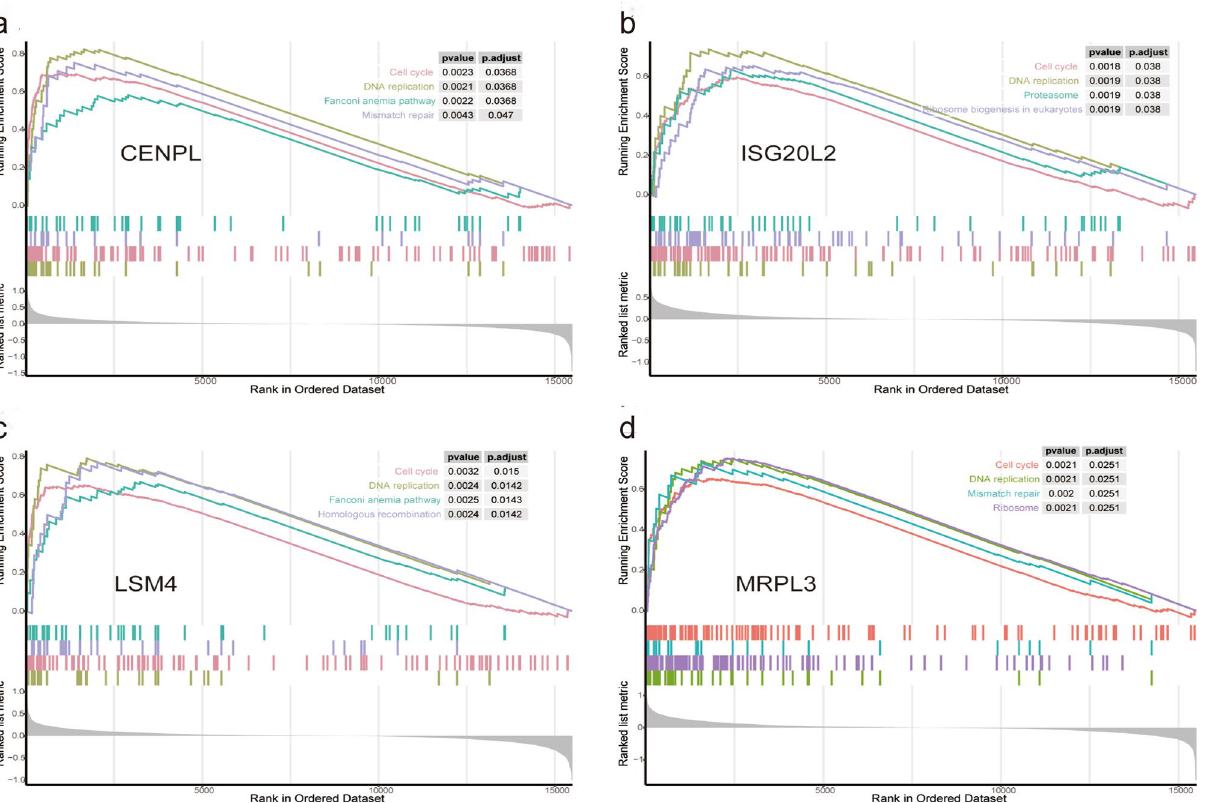
Figure 7. Gene set enrichment analysis (GSEA) of potential hub genes in the METABRC dataset. Tumor cell proliferation related gene-sets were significantly enriched in the high-expression group of each hub gene.